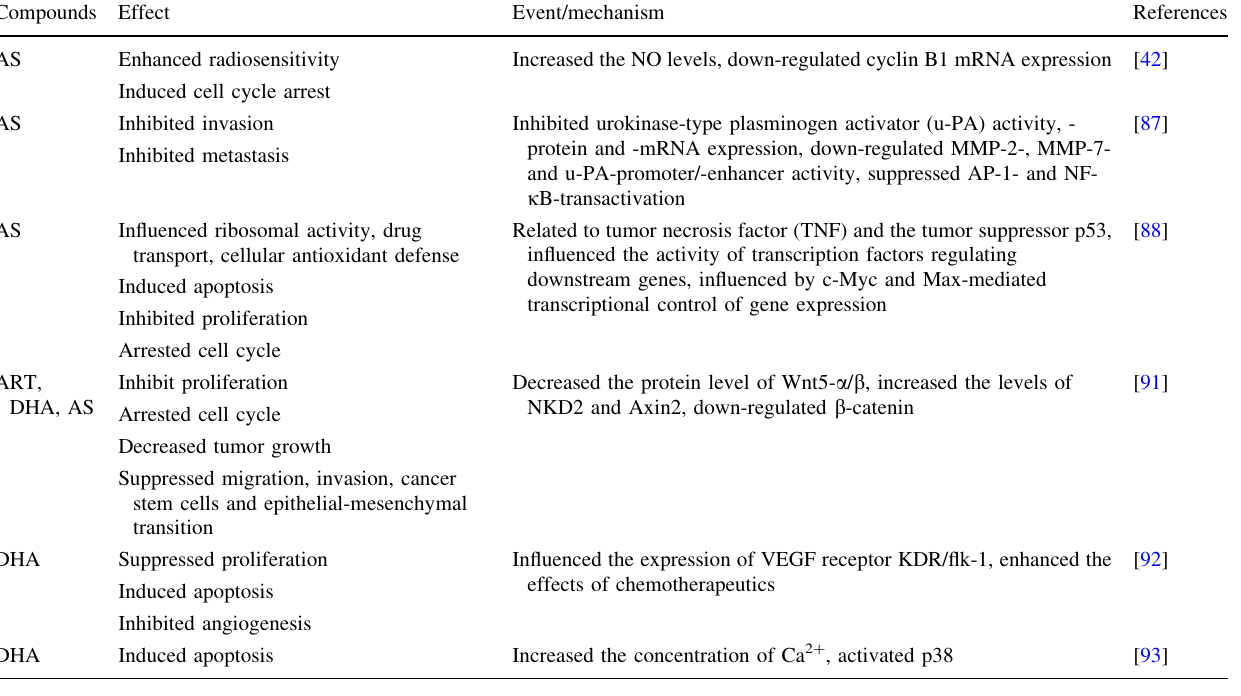
Table 3 Anti-lung cancer cells activities of artemisinins Compounds Effect